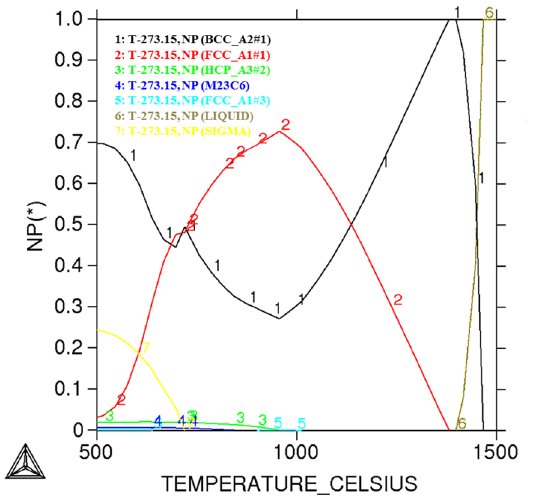
Figure 1. The phase diagram calculated by using the Thermo-Calc software for the newly developed DSS used in the present